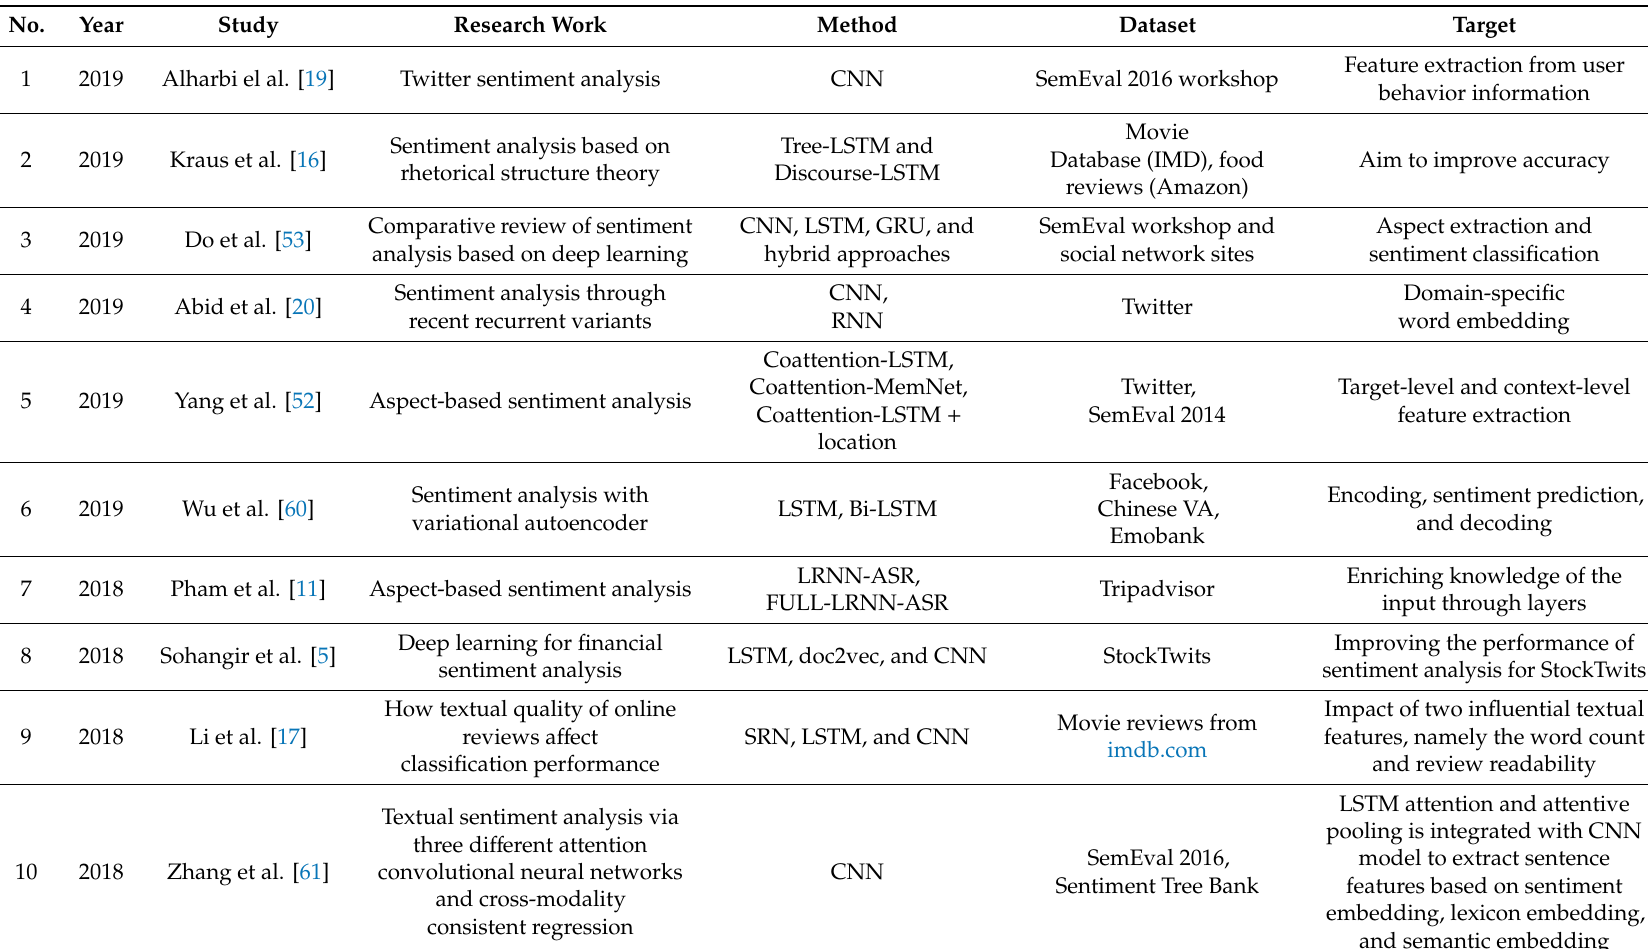
Table 1. Summary of deep-learning-based sentiment